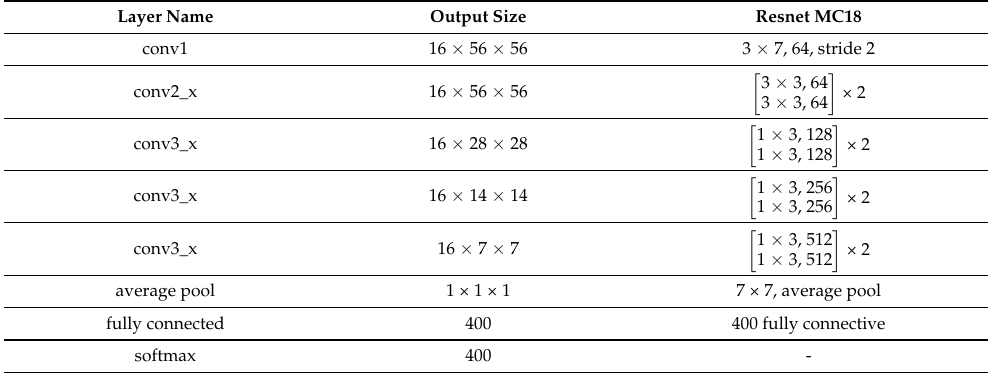
Table 3. Resnet MC18’s architecture.